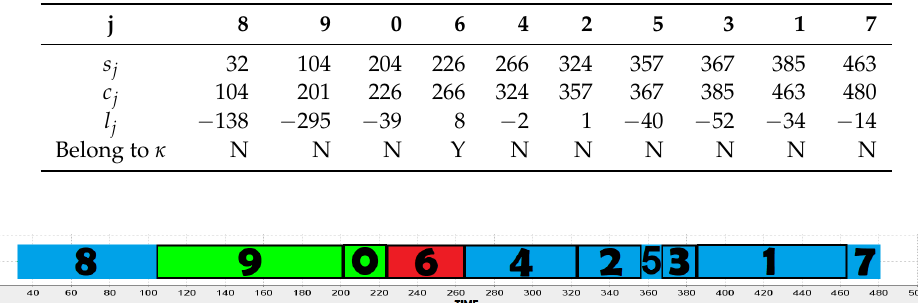
Table 8. Initial solution σ of the instance N_12_10.